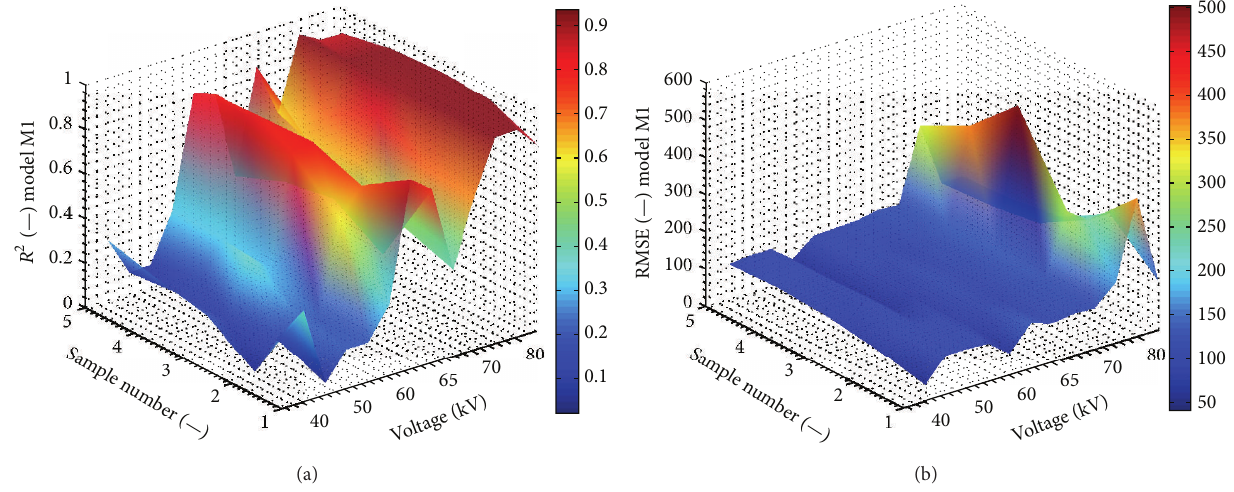
Figure 15: Comparison of 𝑅 2 (a) and RMSE (b) obtained by regression of model M1 for all data samples.